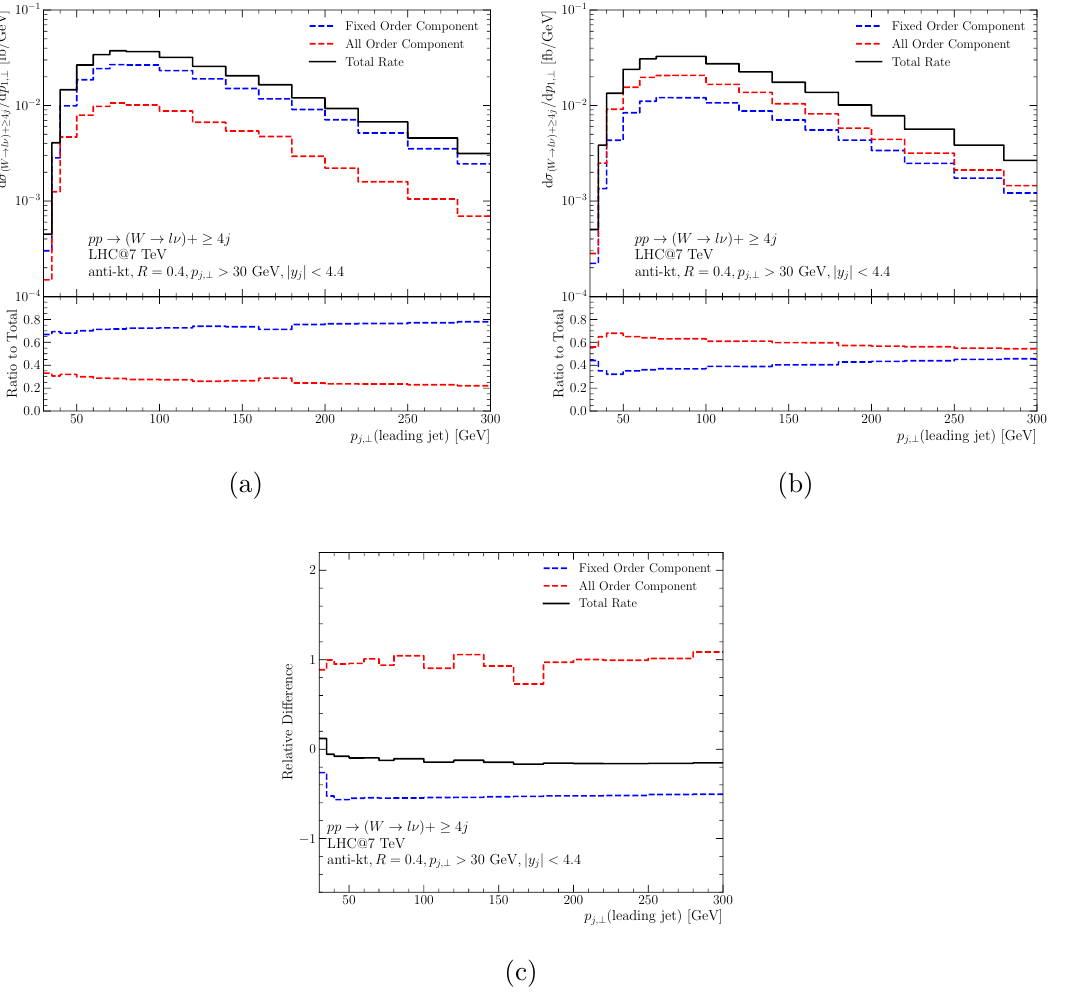
Figure 14. The differential distribution (black, solid) in the transverse momentum of the leading jet in pp → ( W → ‘ν )+ ≥ 4 j , without and with resummation applied to NLL states. The panels and lines are as in figure